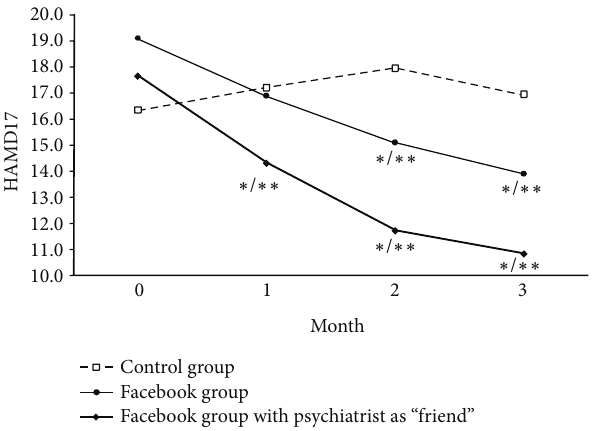
Figure3:GroupF:Facebookwithoutpsychiatristas“friend”;Group FF: Facebook with psychiatrist as “friend.” ∗ 𝑃 < 0.05 compared to Group FF; ∗∗ 𝑃 < 0.05 compared to Group F and Group FF. 𝑃 values from Fisher exact test. The Bonferroni correction was